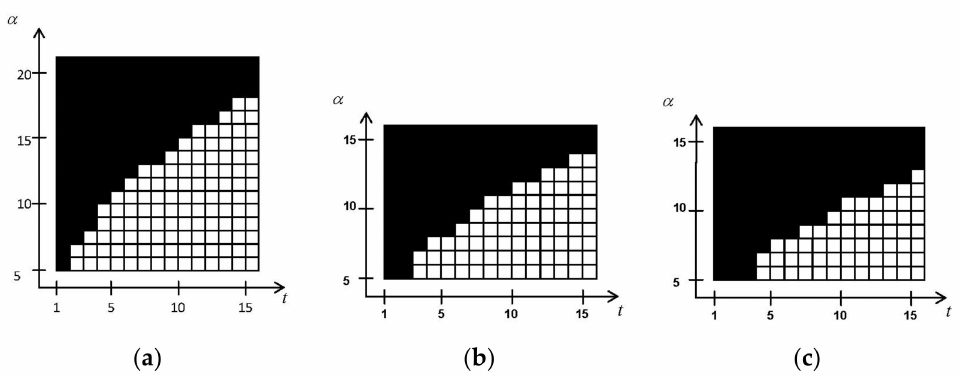
Figure 3. Areas of fulfillment of the inequality MAE 2 ( t ) < MAE 1 ( t ) for ( a ) B = 10, ( b ) B = 25, and ( c ) B =